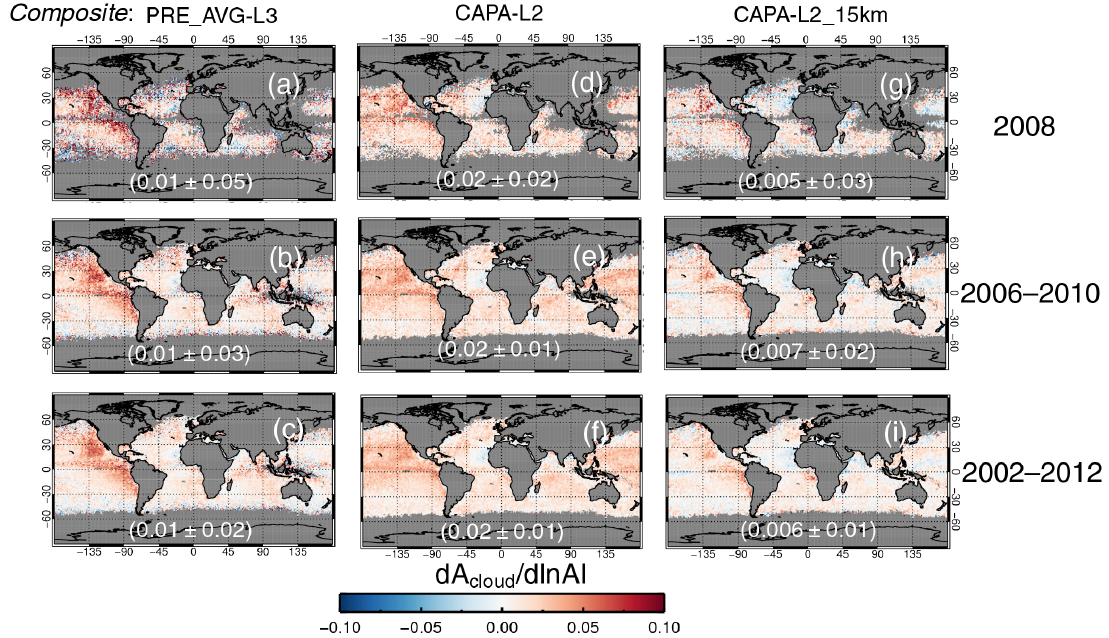
Figure 3. Cloud albedo sensitivity to changes in aerosol index averaged over 1 ◦ × 1 ◦ regions using AATSR. Columns correspond to compos- ites of the data based on the method selection in which the data are pre-averaged (a, b, c) using level-3 daily gridded regions (left column; level 3), paired to the nearest high-resolution aerosol retrieval (d, e, f) and paired to nearest high-resolution aerosol retrieval that is at least 15km away from a cloud (g, h, i) . Paired observations are grouped into JJA periods using 1 year for 2008 (a, d, g) , 5 years from 2006 to 2010, and 10 years from 2002 to 2012. Mean values and standard deviations of the spatial distribution are provided in parenthesis for each plot.